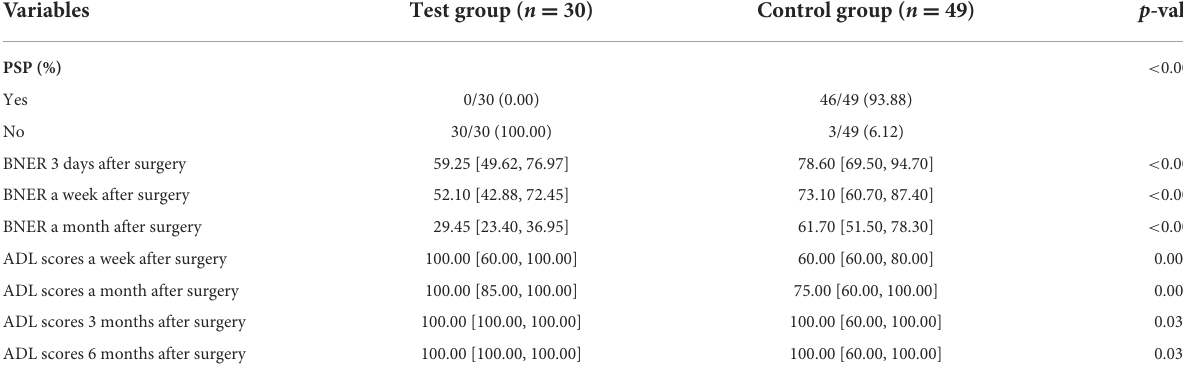
TABLE 2 Complication and prognostic indexes between test group and control